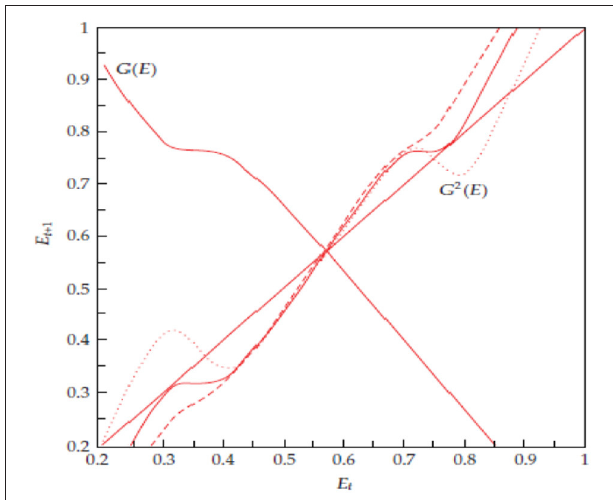
FIGURE 5 | Figure reproduced with the permission of the authors. Source: Naimzada and Sodini [ 11]. Evolution of the second iterate of G (drawn at the bifurcation value A = 0.132). For A = 0.10, G 2 has no intersections with the main diagonal (dashed line); for A = 0.132, G 2 creates 2 tangent points (solid line) and for A = 0.16, two fixed points for G 2 are born (dotted line).